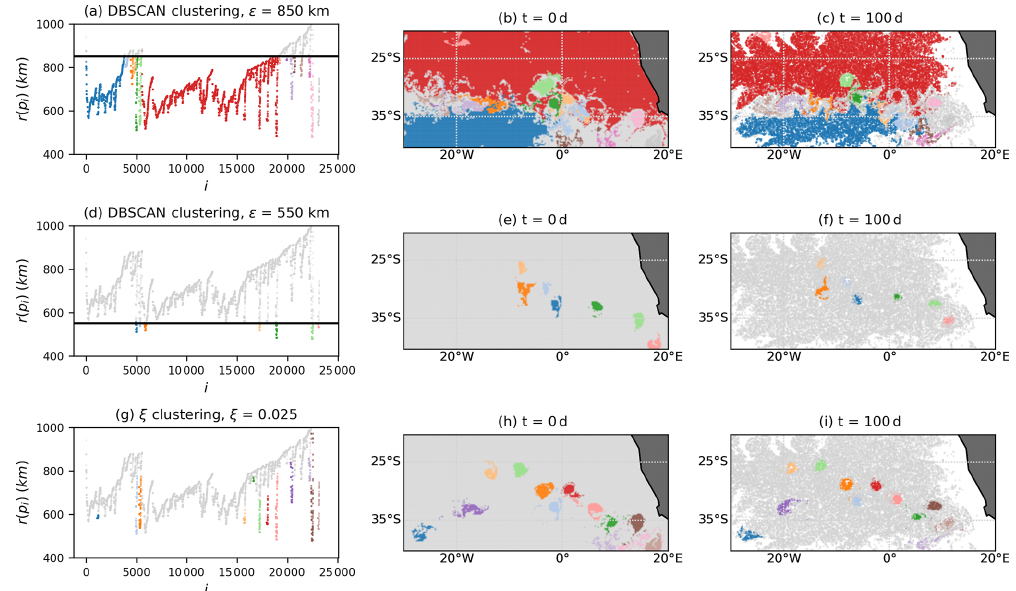
Figure 6. Result of the OPTICS algorithm applied to the direct embedding of the trajectories with different clustering methods. Grey particles correspond to noise.